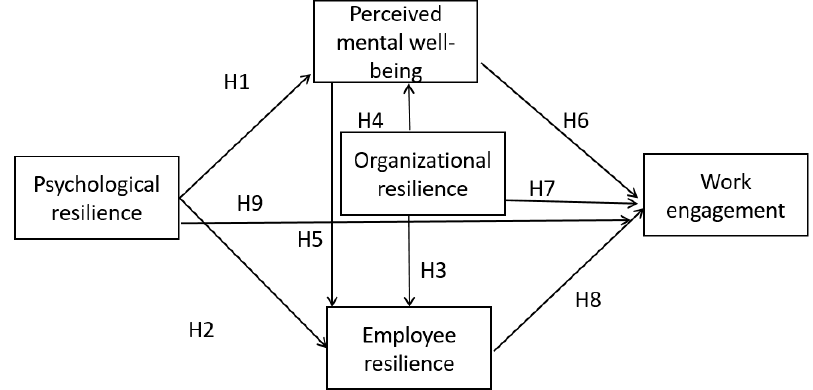
Figure 2. Research model (Source: authors).